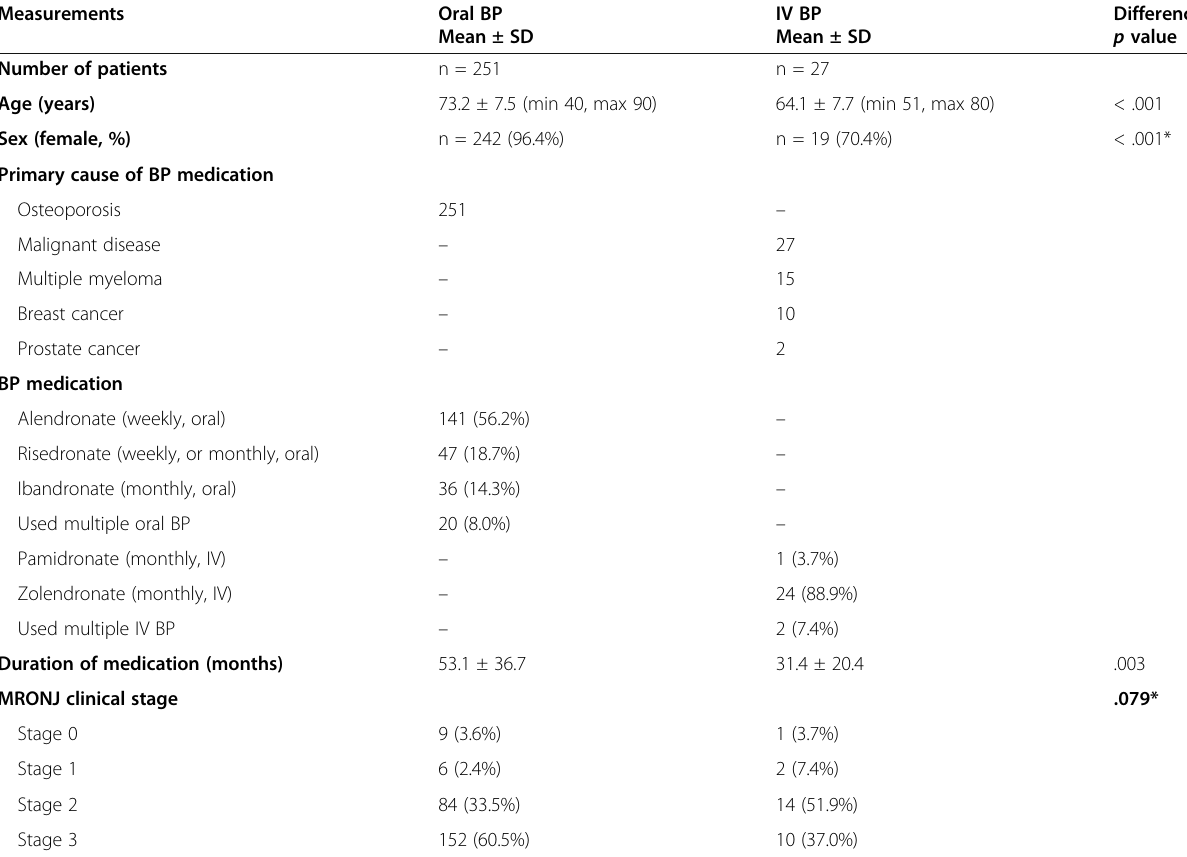
Table 1 Comparison of the demographic and clinical findings of the oral BP and IV BP groups Measurements